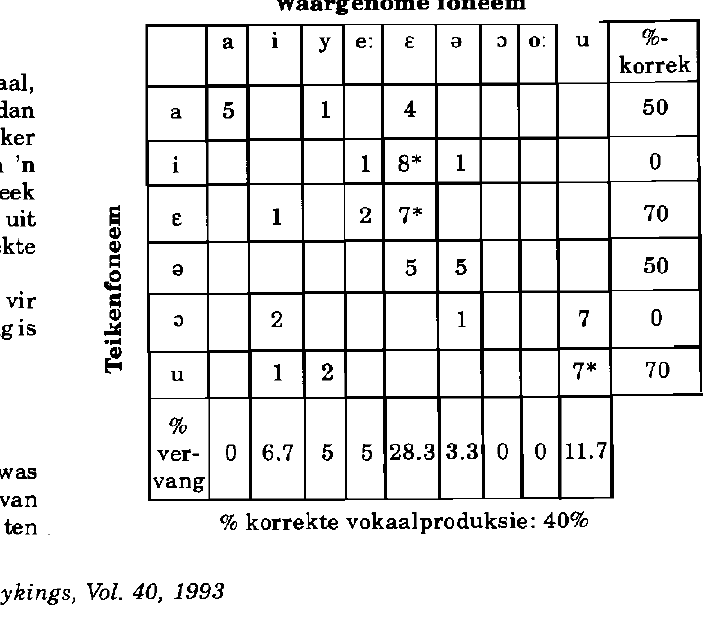
In tabel 8 word die vokaalbeoordelingsmatriks vir Spreker Twee afsonderlik aangetoon. Die uiteensetting is soos in tabel 3.